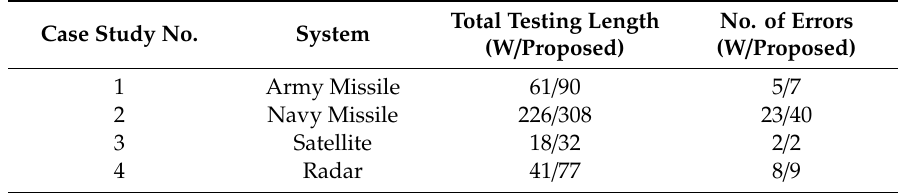
Table 9. Results of case studies.